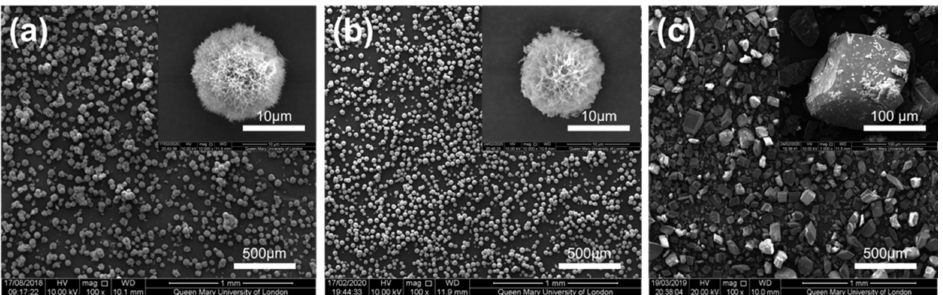
Figure 1. SEM images of ( a ) CHX-SrCl 2 particles; ( b ) CHX-ZnCl 2 particles; ( c ) CHX diacetate particles. The EDS results of the CHX-SrCl 2 particles (Figure 2a–c) indicated an even distribu- tion of strontium and chloride throughout the particle and associated with its structure.